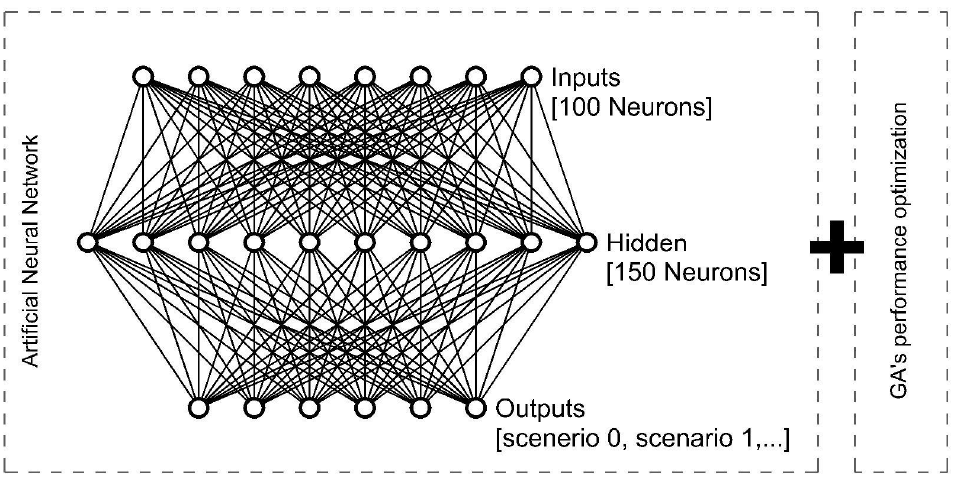
Figure 9. Final artificial neural network structure proposed.